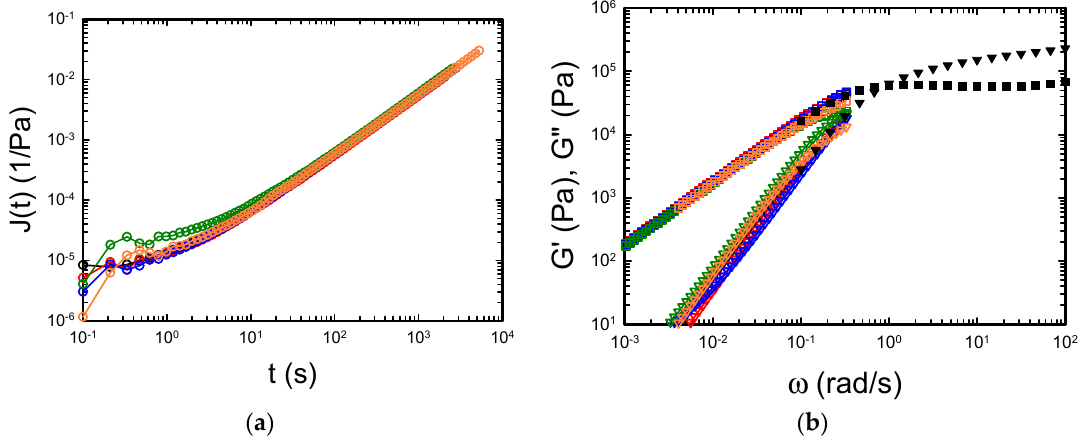
Figure 5. ( a ) Creep data at T = 170 °C; applied stress = 50 Pa. ( b ) Results of the conversion of the creep compliance into dynamic moduli. The color legend for both panels is the same as in Figure 2; squares = loss modulus; triangles = elastic modulus. The dynamic frequency sweep at 170 °C with PP8 is also reported for reference (black symbols).